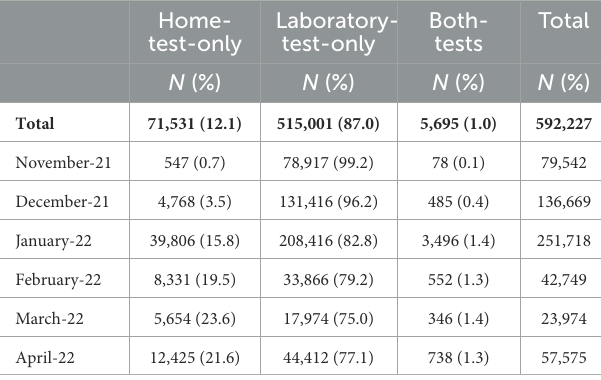
TABLE 1 Trend in test type: November 2021–April 2022. Home- Laboratory- test-only test-only